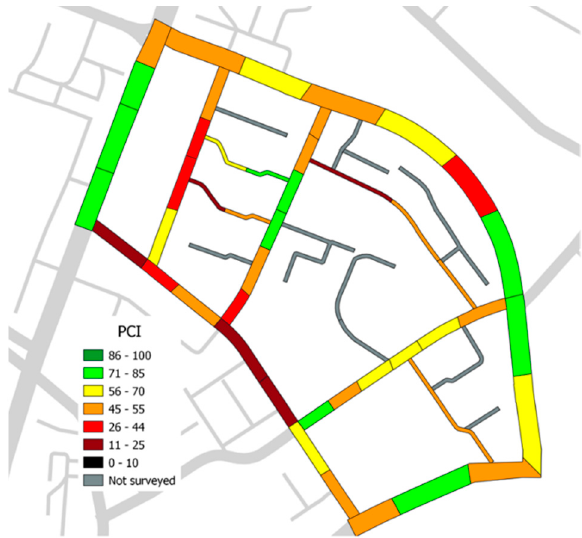
Figure 5. Visualization of PCI results in GIS.